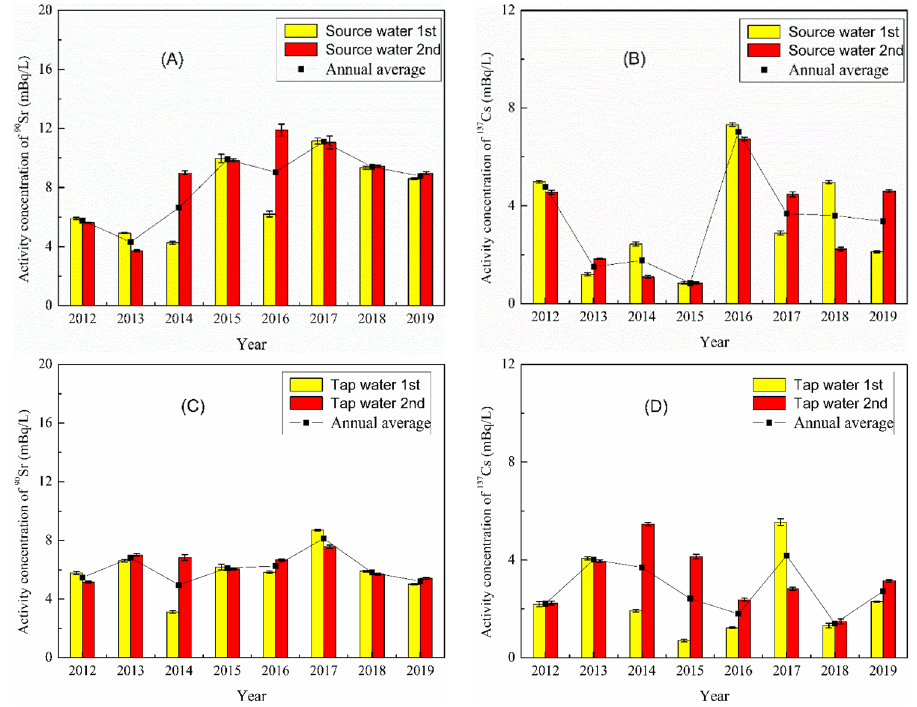
Figure 3. Variation of 90 Sr and 137 Cs activity concentration in source and tap water collected around QNPP during wet (1st) and dry (2nd) seasons in